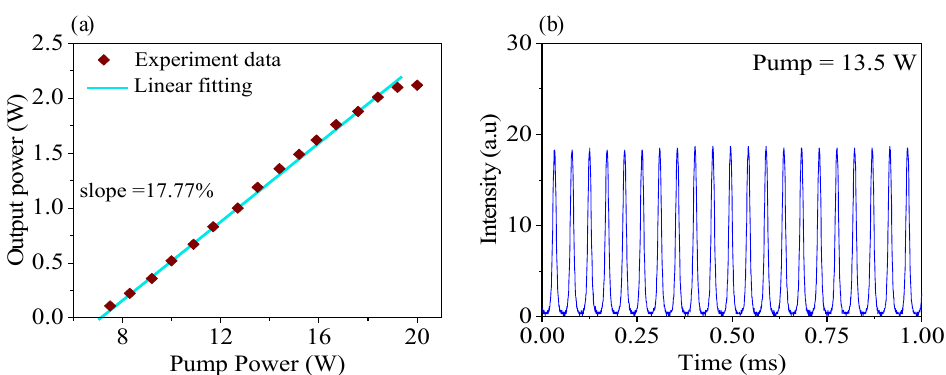
Figure 2. ( a ) Output power of the self-Q-switched Tm:YAP pulsed laser with respect to the incident pump power and ( b ) pulse trains of the Tm:YAP laser at a pump power of 13.5 W. The maximum output power of the Tm:YAP laser at 1944 nm was 2.10 W. The slope efficiency was 17.77%. Note that the output power of the self-Q-switched Tm:YAP laser led to a saturable effect after the pump power increased to 20 W, as shown in Figure 2a.